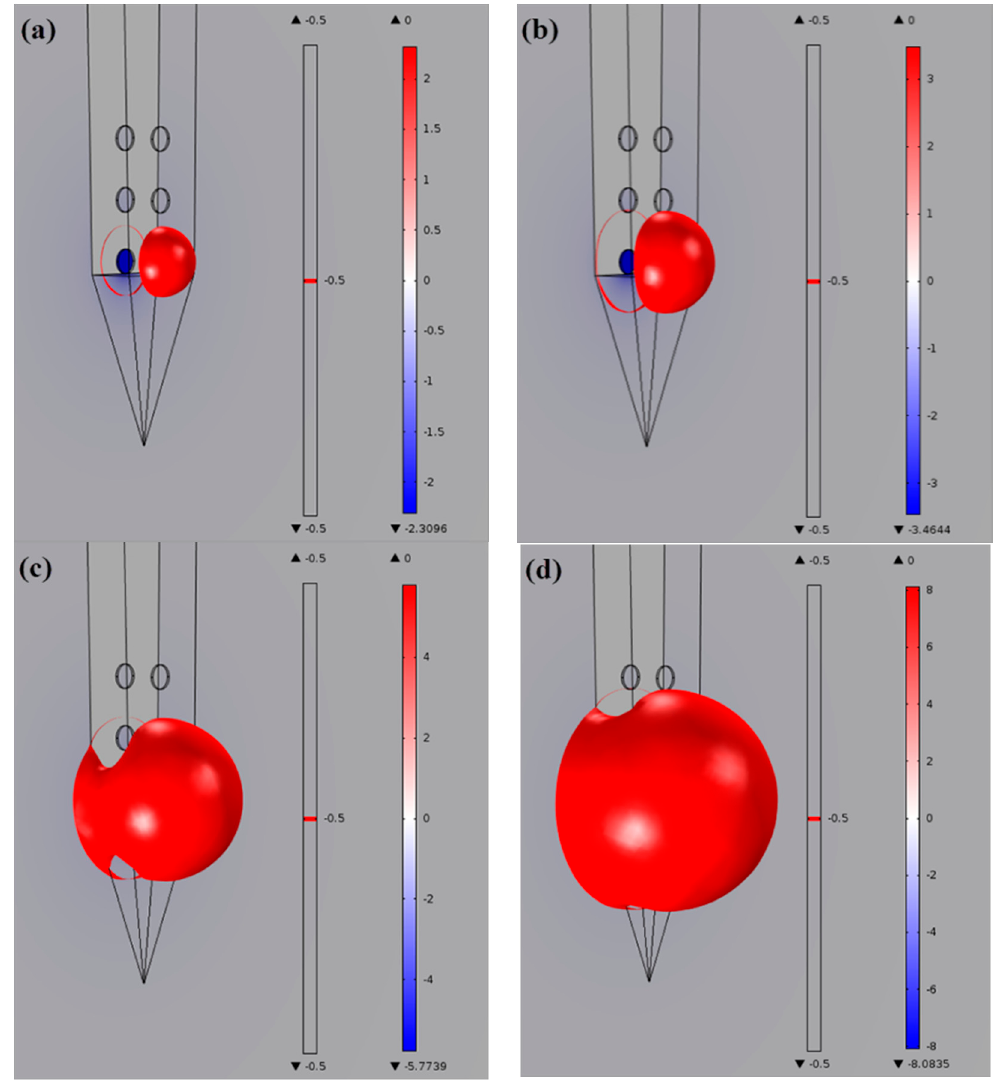
Figure 9. Three-dimensional extracellular potential distribution isosurface based on the extracellular excitation threshold of − 0.5 V generated by monopole stimulation in STN at various stimulus currents ( − 100, − 150, − 250 and − 350 μ A).